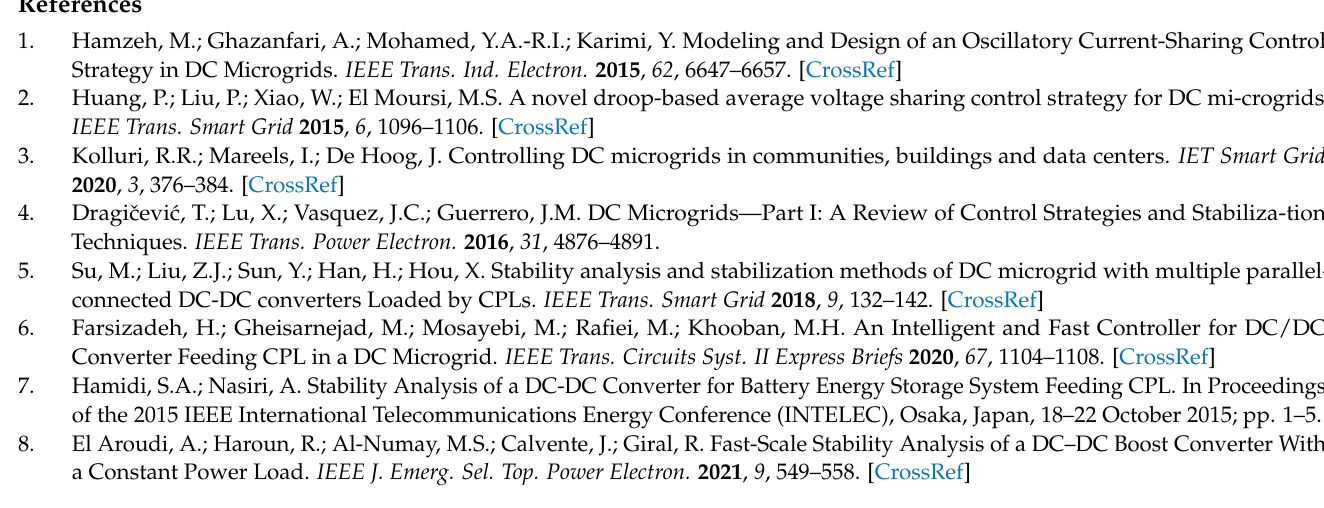
Figure A2. Phase portraits of DDBC with different j a when feeding CPL. ( a ) j a = 3; ( b ) j a = 5; ( c ) j a = 7; ( d ) j a = 9; ( e ) j a =